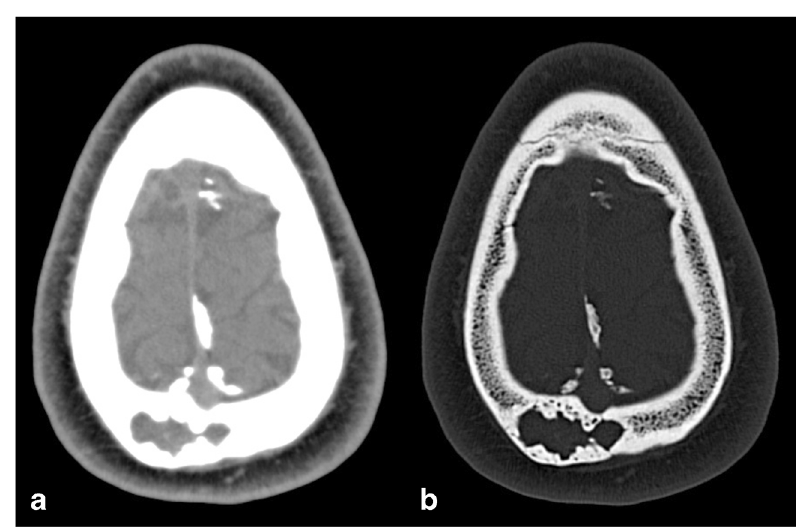
Fig. 6 Aneurysmal bone cyst (ABC). Axial CTimages with brain ( a ) and bone ( b ) windows show a left frontal lytic lesion with blood-fluid levels, associated with a diffuse ground-glass modification of the frontal bone, related to the presence of a fibrous dysplasia. Magnetic resonance (MR)